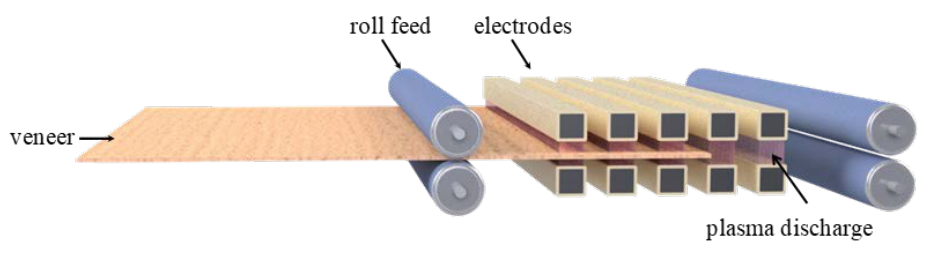
Figure 2. Plasma